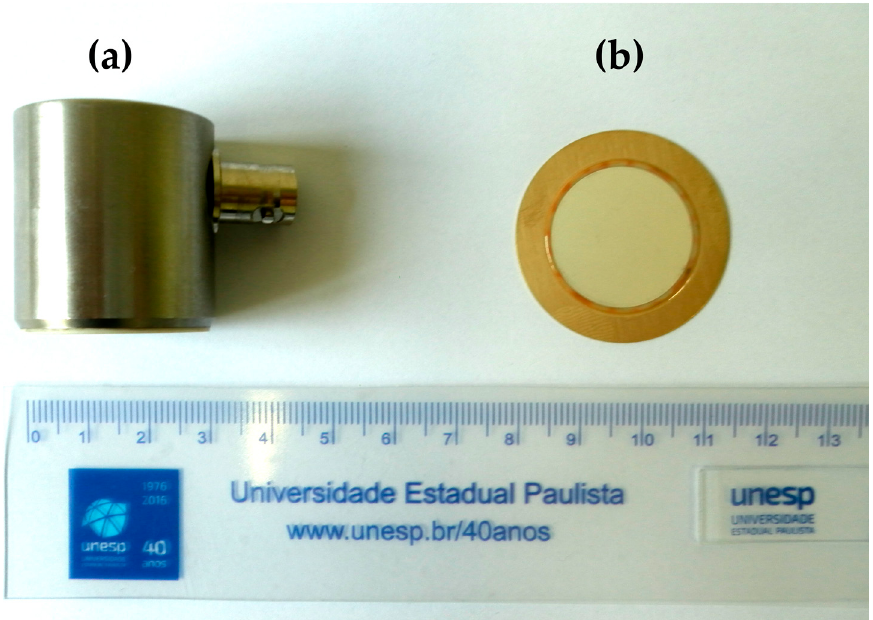
Figure 1. Sensors used in this study: ( a ) conventional RS15I-AST sensor [20] consolidated in AE applications; and ( b ) alternative low-cost piezoelectric diaphragm (buzzer) [21].